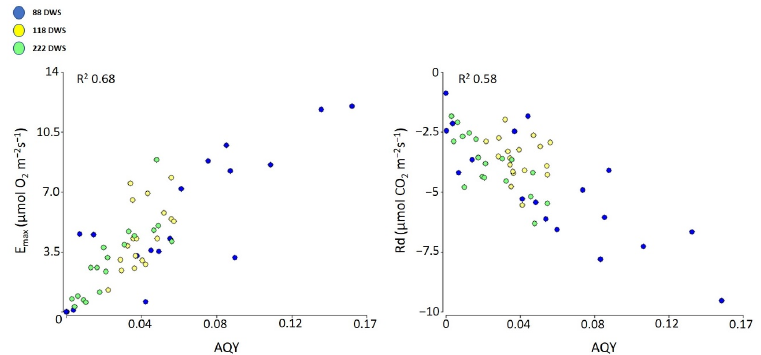
Figure A2. Linear regression between Emax ( left ) and Rd ( right ) with AQY.